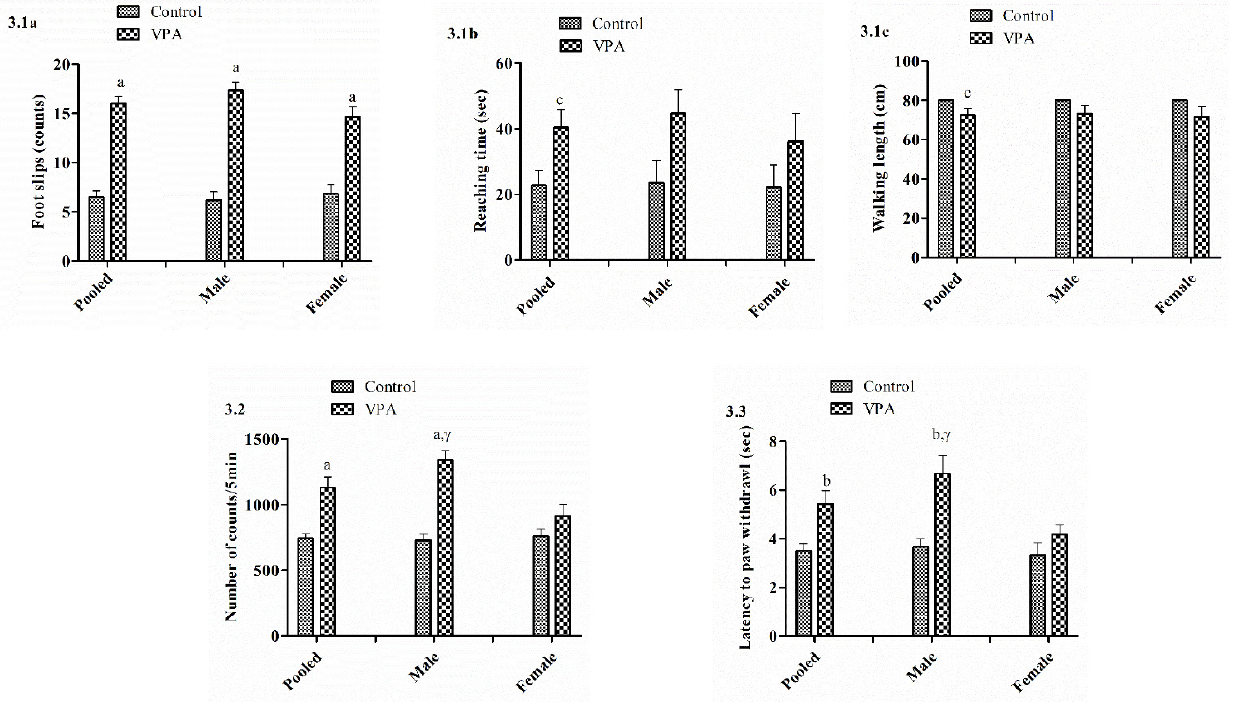
Figure 3. ( 3.1 ) Motor coordination ability of male and female BALB/c mice following administration of sodium valproate (VPA, 400 mg/kg s.c.) was measured using the balance beam test on postnatal day 25: ( a ) foot slips, ( b ) reaching time (s), ( c ) walking length. ( 3.2 ) Locomotion due to hyperactivity measured in male and female BALB/c mice following administration of sodium valproate (VPA, 400 mg/kg s.c.) using the actophotometer on postnatal day 35. ( 3.3 ) Nociceptive response of male and female BALB/c mice following administration of sodium valproate (VPA, 400 mg/kg s.c.) was assessed by using Eddy’s hot plate on postnatal day 38. Data expressed as mean ± SEM. Pooled, n = 12; males, n = 6; females, n = 6. a p < 0.001, b p < 0.01, c p < 0.05 vs. sex-matched control group; α p < 0.001, β p < 0.01, γ p < 0.05 vs. VPA-treated female mice (using t -test), n.s, non-significant ( p > 0.05).